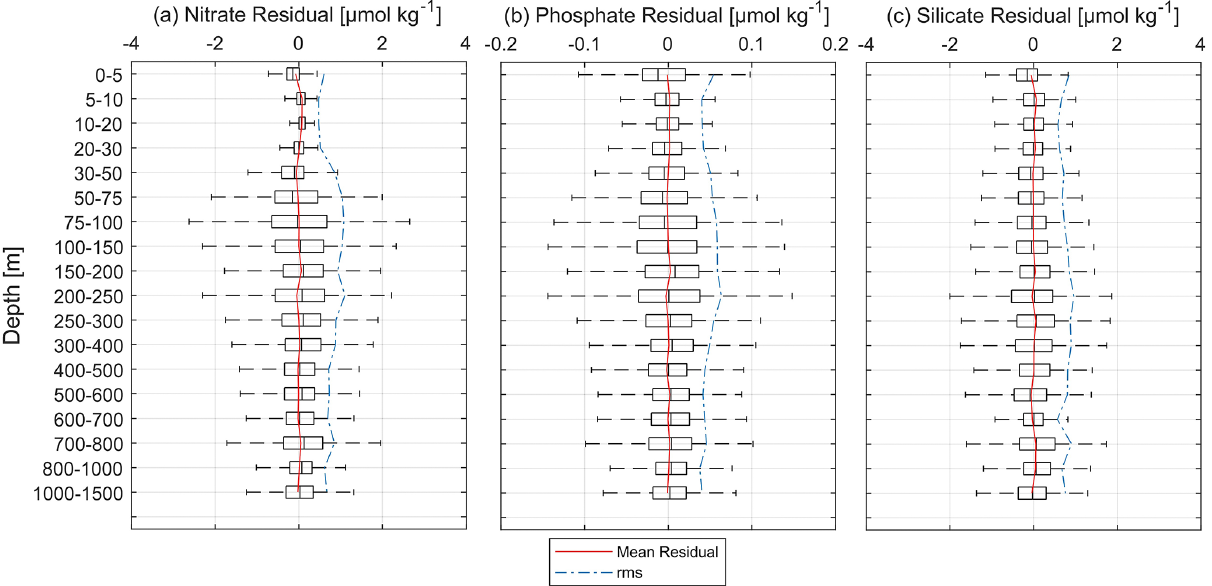
Figure 7. Vertical mean residuals (in red), i.e., the differences between the observations and the analysis, and the mean rms (dashed blue) of (a) nitrate, (b) phosphate and (c)